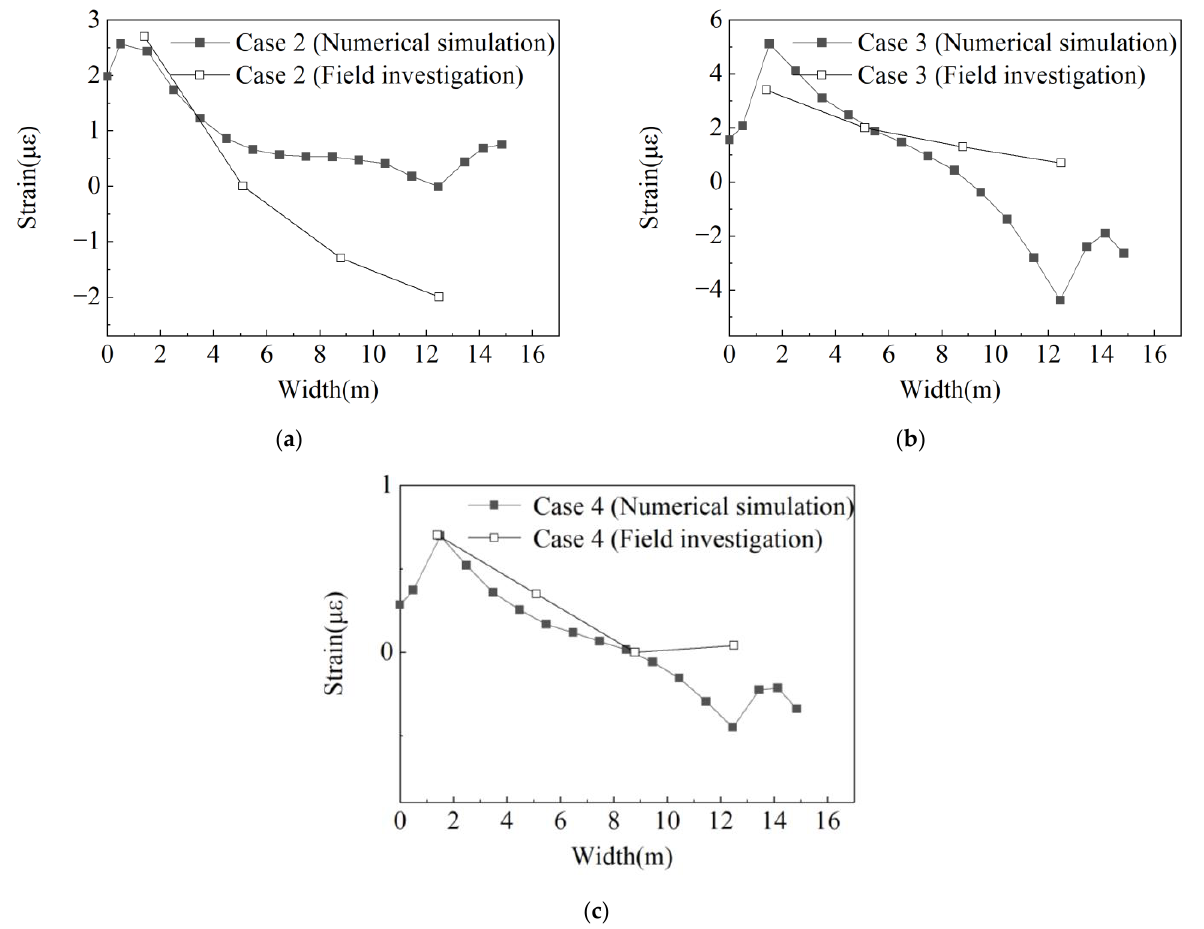
Figure 6. Comparisons of strain of top slab between numerical simulation and field investigation: ( a ) Case 2; ( b ) Case 3 and ( c ) Case 4 (unit: με ) . ( a ) Case 2; ( b ) Case 3 and ( c ) Case 4 (unit: µε